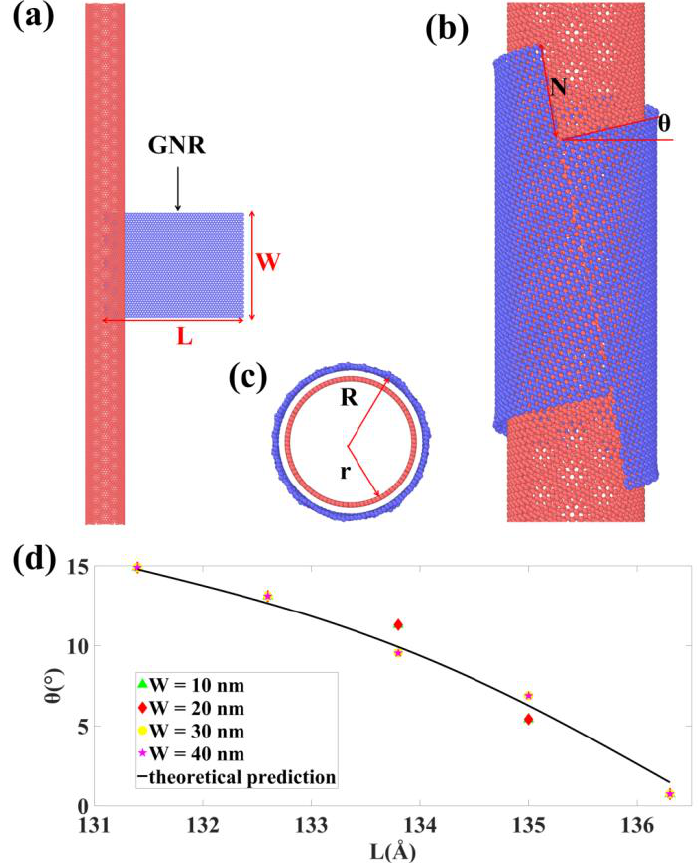
Figure 2. Geometrical relationships between helical angle and the sizes of SWCNTs and GNRs. The resultant θ from simulations agree well with predictions from Equation (1). ( a ) the starting model for simulations, ( b , c ) the final configuration after wrapping from side and top views and ( d ) the plot of θ as a function of L from both MD simulations and Equation